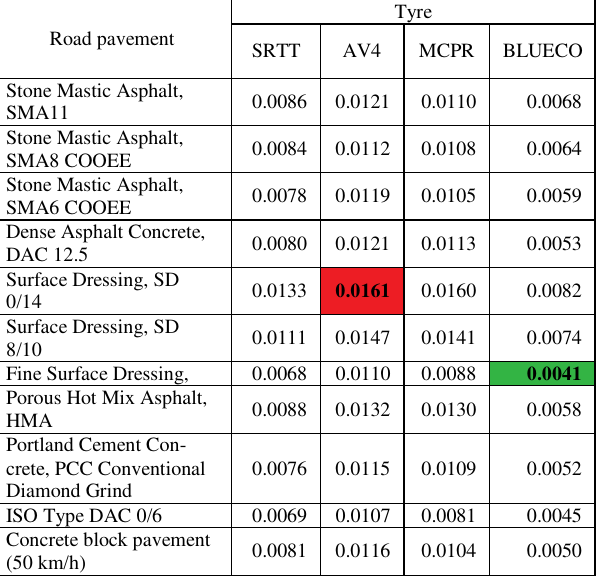
Table 2. Coefficients of rolling resistance for selected road surfaces meas- ured at TUG conditions Road